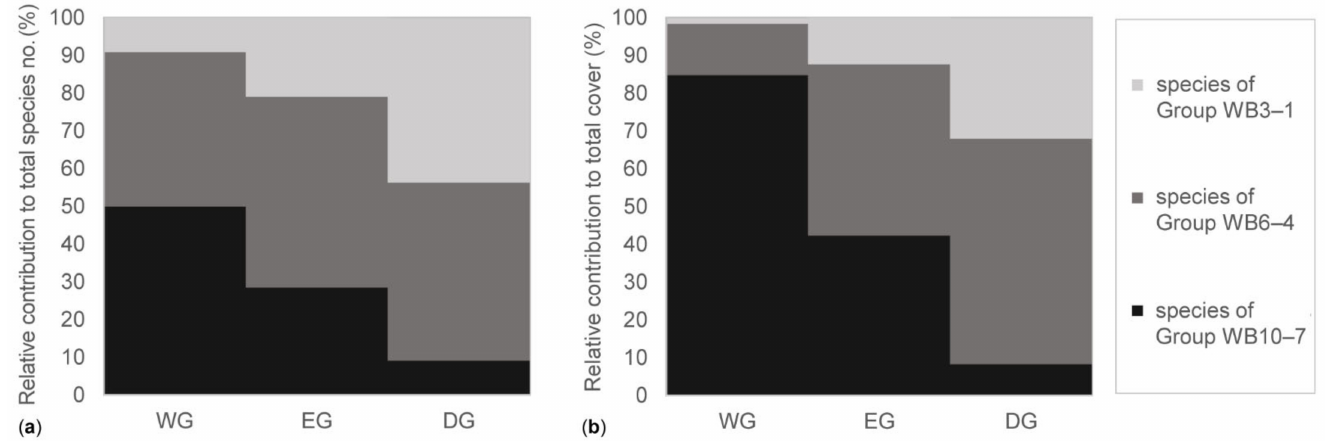
Figure 2. Relative contributions to the total species number ( a ) and to the total cover ( b ) by the species belonging to the given WB groups in the above-ground vegetation of the three grassland types. Notation: WG—wet grassland type; EG—ecotone grassland type; DG—semi-dry grassland type. WB groups were created by grouping the WB categories from the system of Borhidi [31], where “Group WB10–7” was for species that are most associated with high, “Group WB6–4” was for species that are associated with moderate, and “Group WB3–1” was for species that are most associated with low soil moisture content.